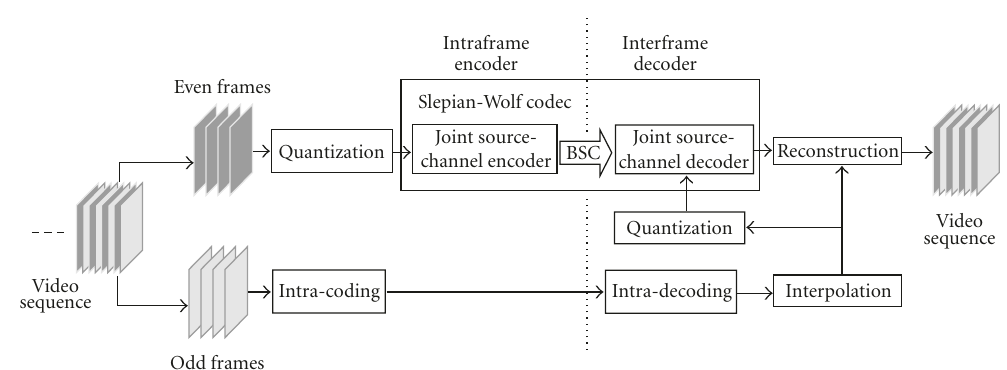
Figure 2: Block diagram of the pixel-domain distributed video coding system.